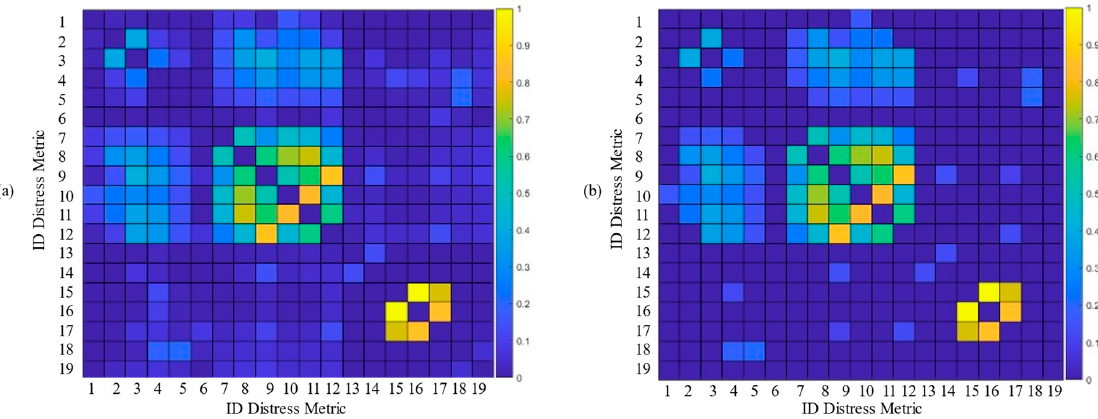
Figure 11. Adjacency matrix coefficients a 𝑖,𝑗 = 0,…𝑃 − 1 of the graph of the metrics, calculated as the correlation coefficients between the i -th and j -th distress metric values: ( a ) original values and ( b ) thresholded values with threshold ϑ = 0.1.